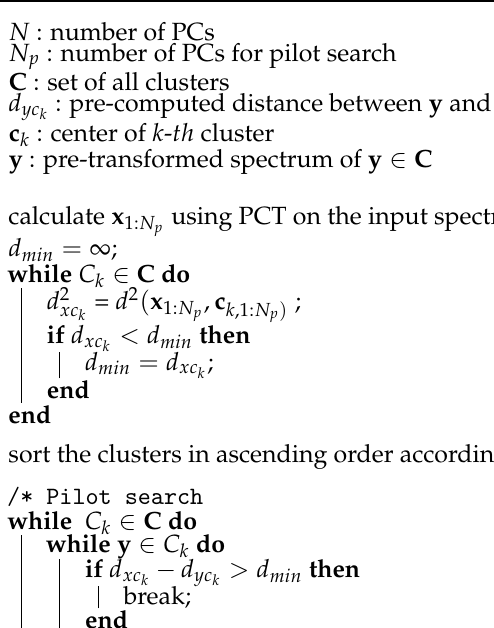
Algorithm 1: Proposed